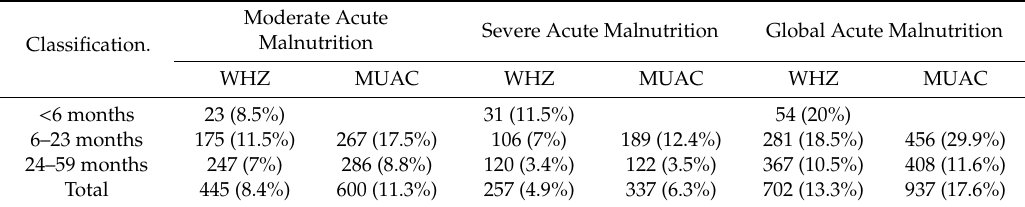
Table 3. Distribution of the nutritional status of children under five years of age in Ibb and Sana’a governorates by MUAC * and WHZ ** according to age